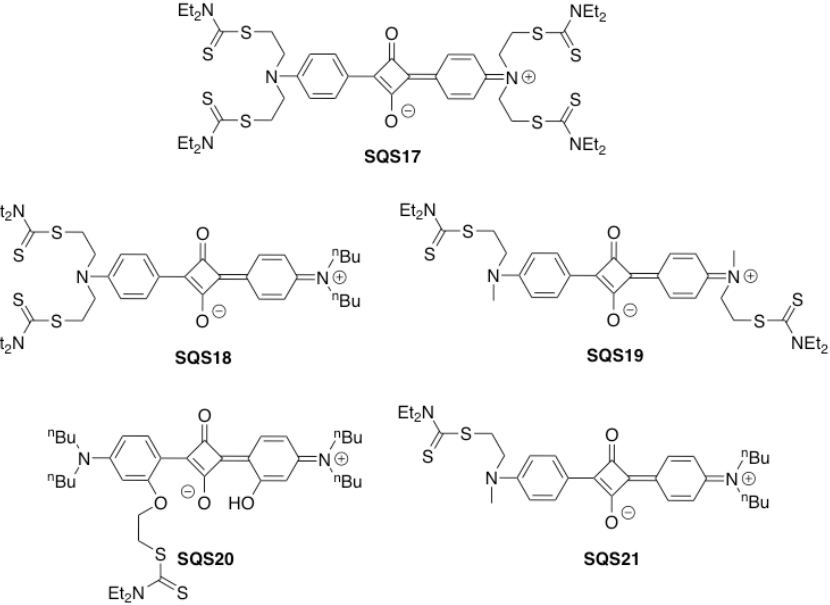
Figure 3. Structures of thiocarbamate-containing SQS17 [75], SQS18 [76], SQS19 [77], SQS20 [78], SQS21 [79]. SQS21